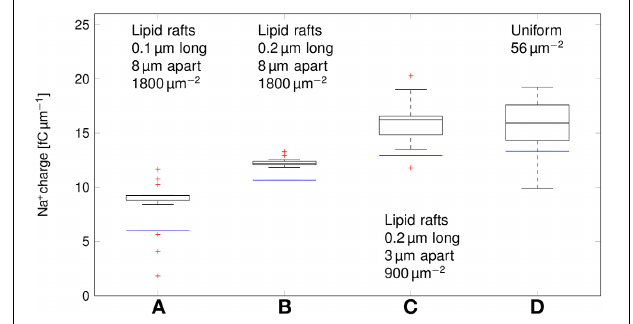
FIGURE 6 | Metabolic cost of action potentials for different channel distributions in a 0.1 µ m diameter C-fiber axon. Data was obtained using both deterministic (blue lines) and stochastic (boxes) simulations. (A) l = 0 . 1 µ m , L = 8 µ m, optimal values given by Zeng and Tang (2009), Na + channel density 1800 µ m − 2 , (B) l = 0 . 2 µ m , L = 8 µ m, Na + channel density 1800 µ m − 2 , (C) l = 0 . 2 µ m , L = 3 µ m, Na + channel density 900 µ m − 2 , based on data on lipid raft placement given by Pristerà et al. (2012) and personal communication with Amber Finn, (D) Uniform distribution. On each box, the central mark is the median, the edges of the box are the 25th and 75th percentiles, the whiskers extend to the most extreme data points not considered outliers, and outliers are plotted